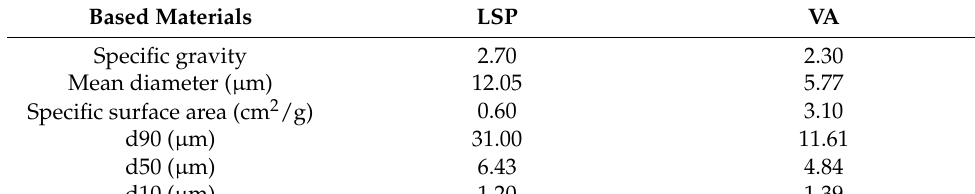
Table 3. Physical characteristics of raw volcanic ash powder and limestone powder.